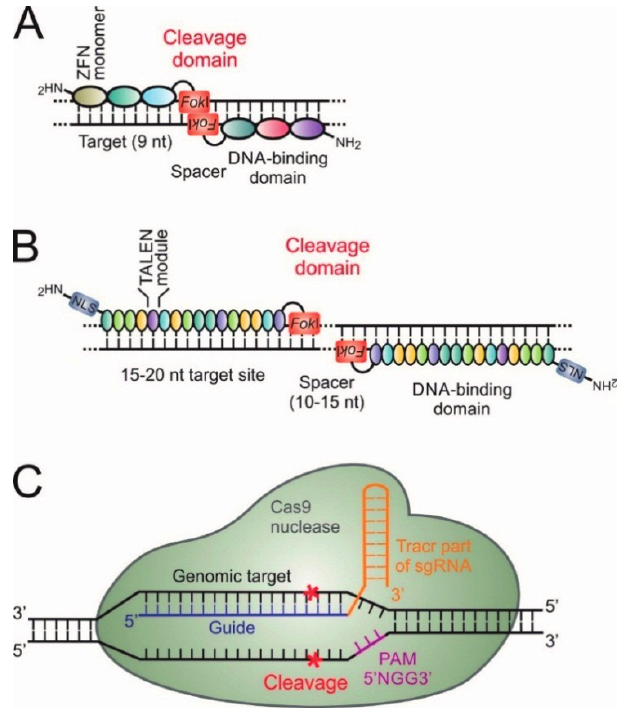
Figure 3. Engineered nucleases used in genome and epigenome editing. ( A ) Zinc finger nucleases (ZFNs) containing three zinc finger modules recognize a nine-nucleotide target DNA sequence on the sense and antisense strands. Fok I dimerization effects cleavage of both strands at the target site situated in the 5–7 nucleotide spacer region or cleavage domain; ( B ) Transcription activator-like effector nucleases (TALENs) comprise approximately 16 modules for each of the left and right subunits. Each module contains 33–35 amino acids that bind a single nucleotide at the repeat variable diresidue (RVD) at amino acids 12 and 13. Much like ZFNs, the Fok I nuclease domain must dimerize to cleave each of the strands of the duplex DNA; ( C ) Clustered regulatory interspaced short palindromic repeats (CRISPR) and CRISPR associated (Cas) proteins system with single guide RNA (sgRNA) comprising a combination of naturally occurring CRISPR RNA (crRNA) and transactivating CRISPR RNA (tracrRNA). The sgRNA guides the Cas9 endonuclease by binding genomic DNA with the aid of an obligate upstream protospacer adjacent motif (PAM) sequence to effect site-specific cleavage. nt: nucleotide. Red asterisks: cleavage